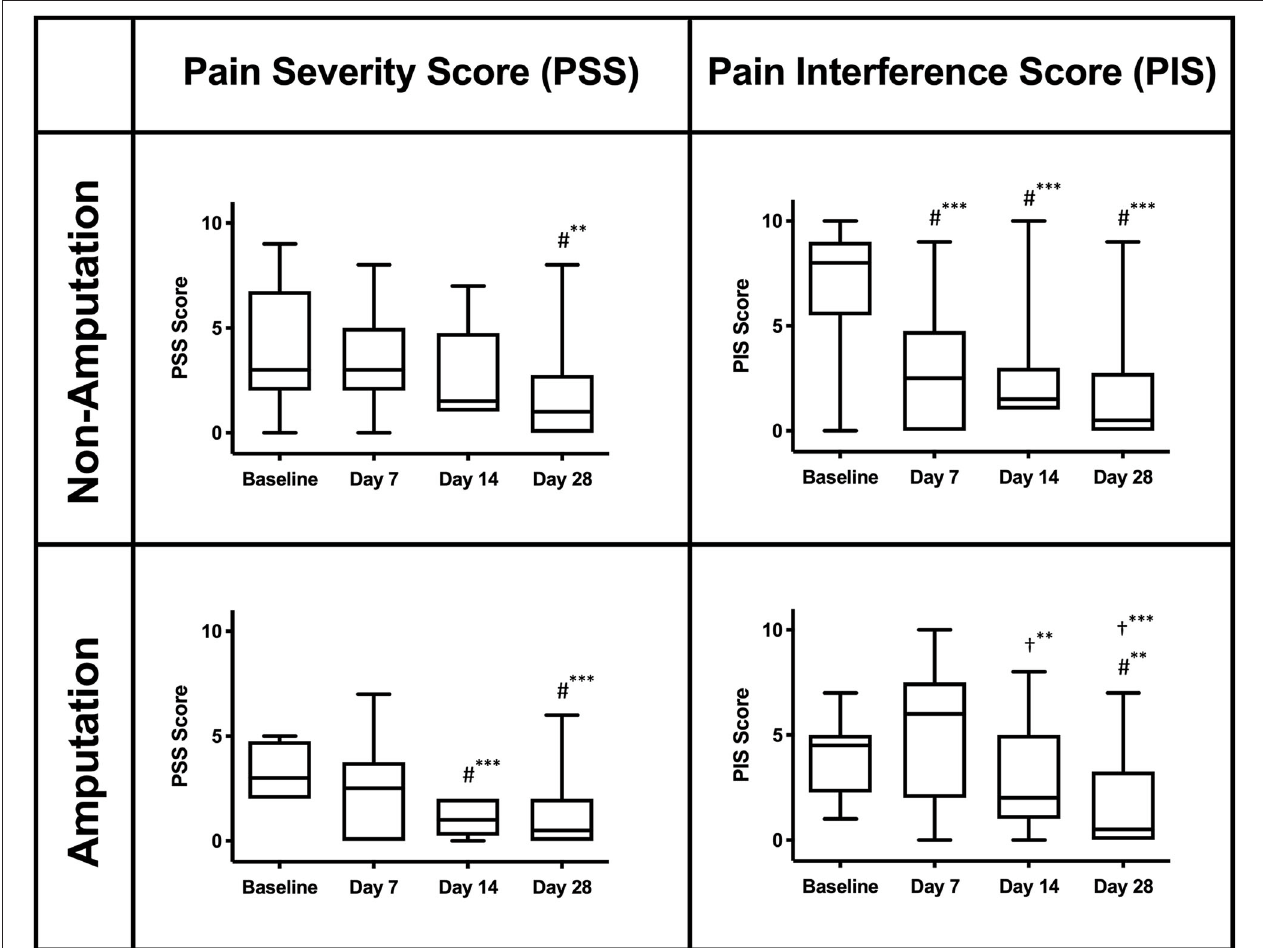
FIGURE 2 | Canine Brief Pain Inventory scores (PSS and PIS) for the affected limb in dogs with and without amputation. A reduction in score indicates a clinical improvement. (#) denotes a significant difference compared to baseline. (†) denotes a significant difference compared to day 7. **Significant difference ( p < 0.05). ***Significant difference ( p <